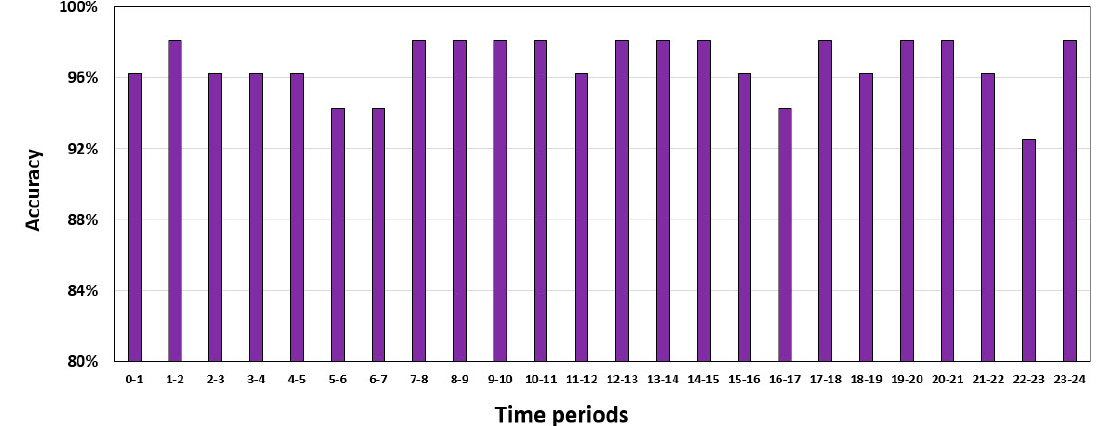
Figure 14. The accuracies of scenario of the OOC analyzing network in extended period conditions.